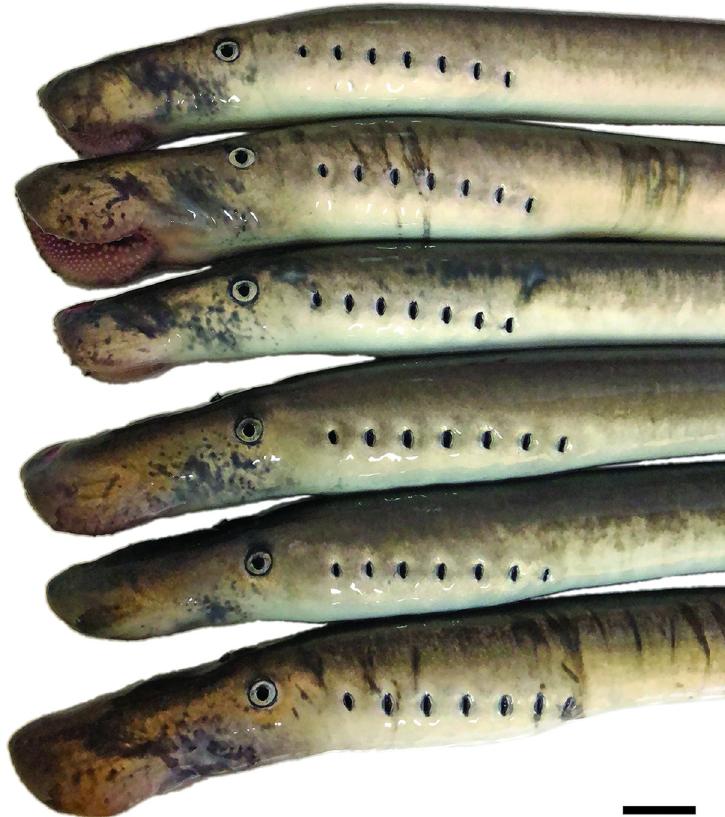
Fig 11. Prebranchial and branchial regions of six G . macrostoma from the Santa Cruz River showing the variation in size from snout to eye and size of the oral disc. Scale bar = 2 cm.